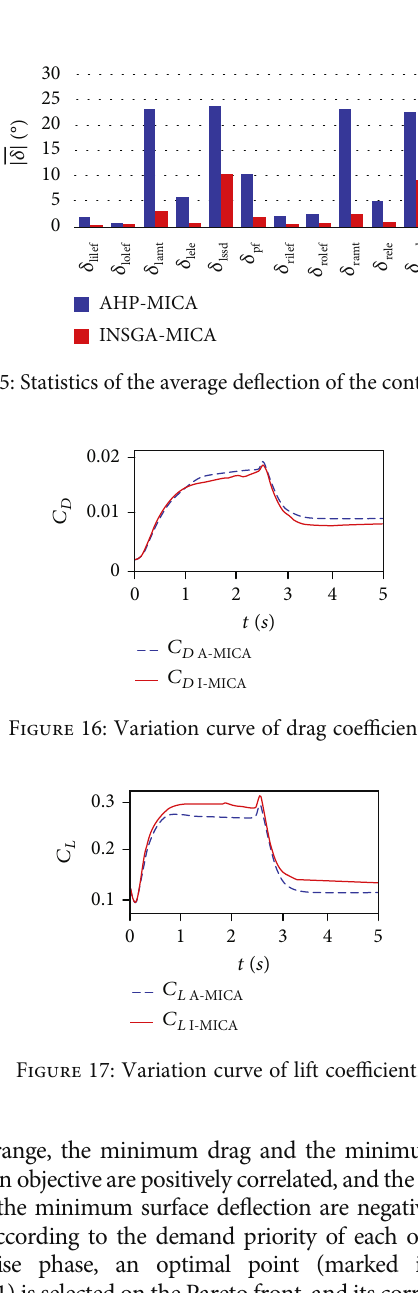
 . Figure 12 is a com-